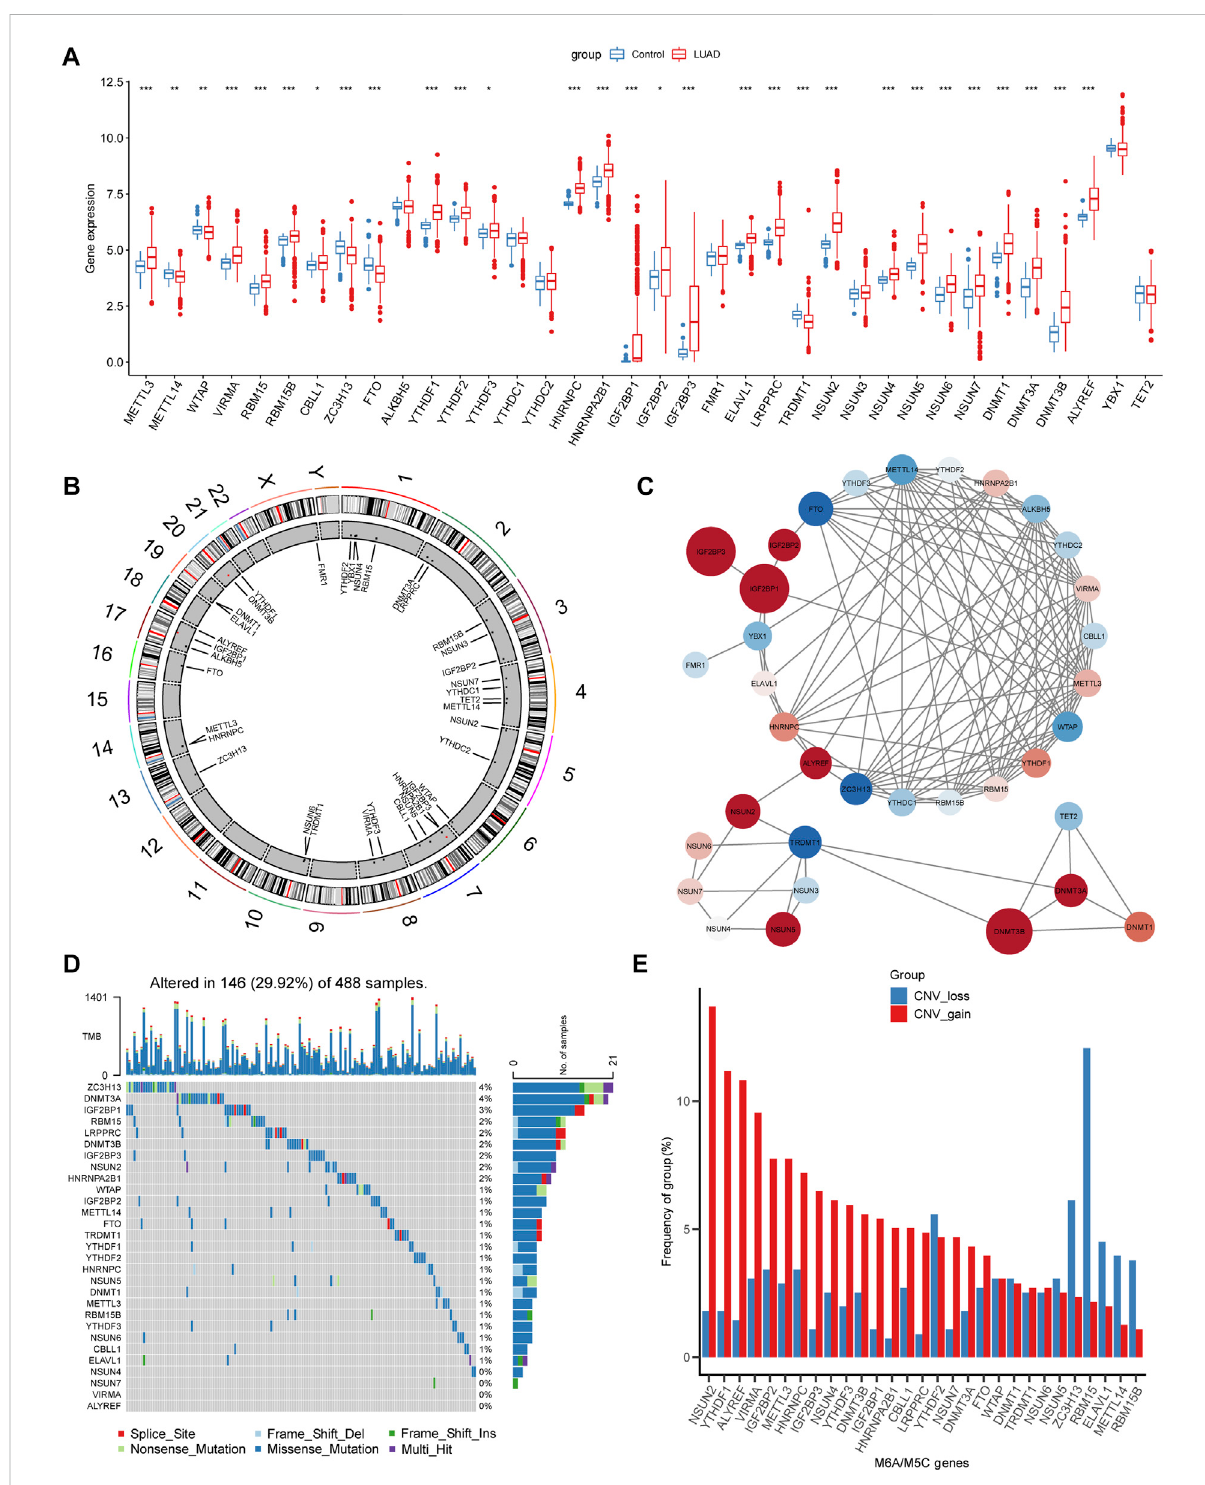
FIGURE 2 Landscapesofm5c/m6a-related genesinLUAD. (A) Boxplot illustrates theexpressionlevels of36m5a/m6a-relatedgenesinnormal andLUAD tissues. (B) Chromosome locations of 36 m5a/m6a-related genes. (C) PPI network of m5a/m6a regulators. The color of nodes represents log2FC, and the size of nodes represents |log2FC| (log2FC was obtained as the result of difference analysis between TCGA normal samples and LUAD samplesbyDEseq2.)Red:log2FC > 0;blue:log2FC < 0. (D) Waterfalldiagramsshowthemutationfrequencyofm5a/m6a-relatedgenes. (E) CNV frequency of m5a/m6a-related genes. Red bars: CNV gain; blue bars: CNV loss. (*: p < 0.05, **: p < 0.01, and ***: p <